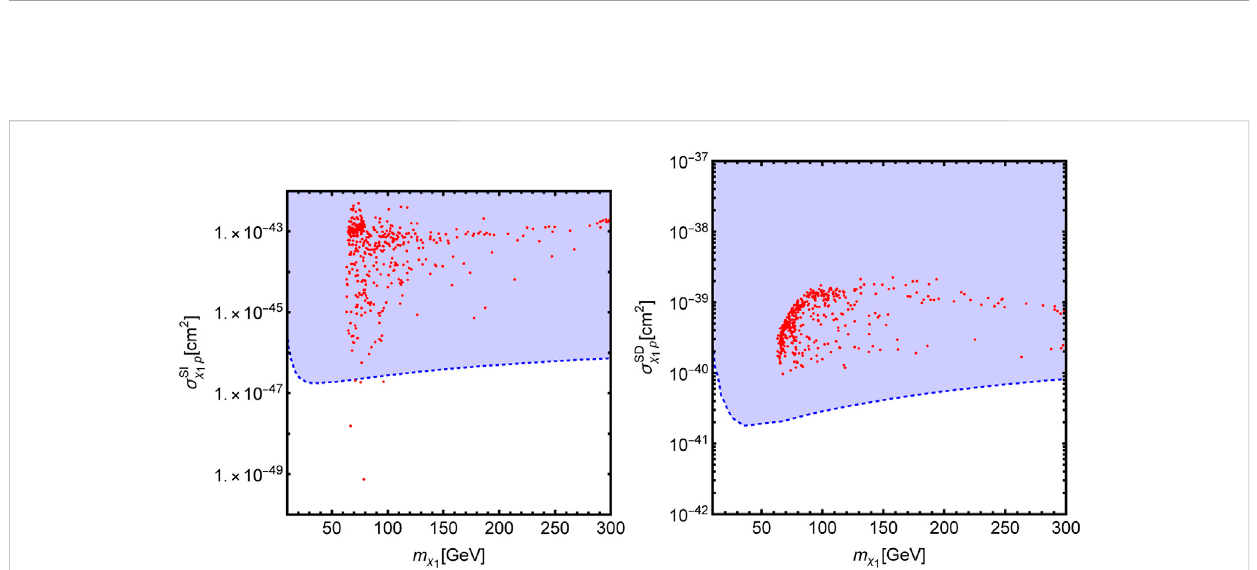
FIGURE 3 Model points of the minimal singlet – doublet model complying with CDF excess and DM relic density shown in the ( m χ The blue regions are experimentally